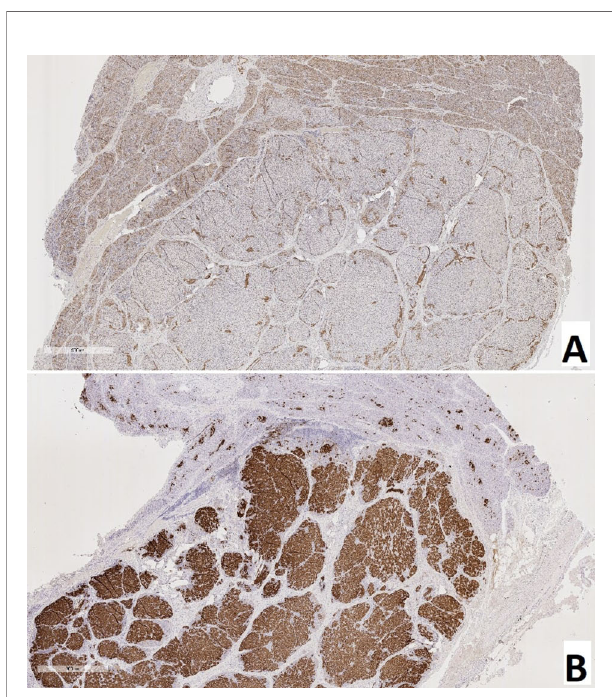
FIGURE 10 | Pancreas of a patient with a focal form of congenital hyperinsulinism. (A) – NeuroD1, (B) – insulin;